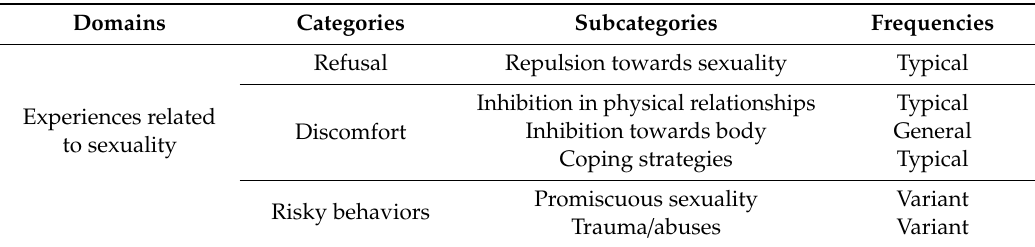
Table 4. Domains, categories and subcategories of the area of